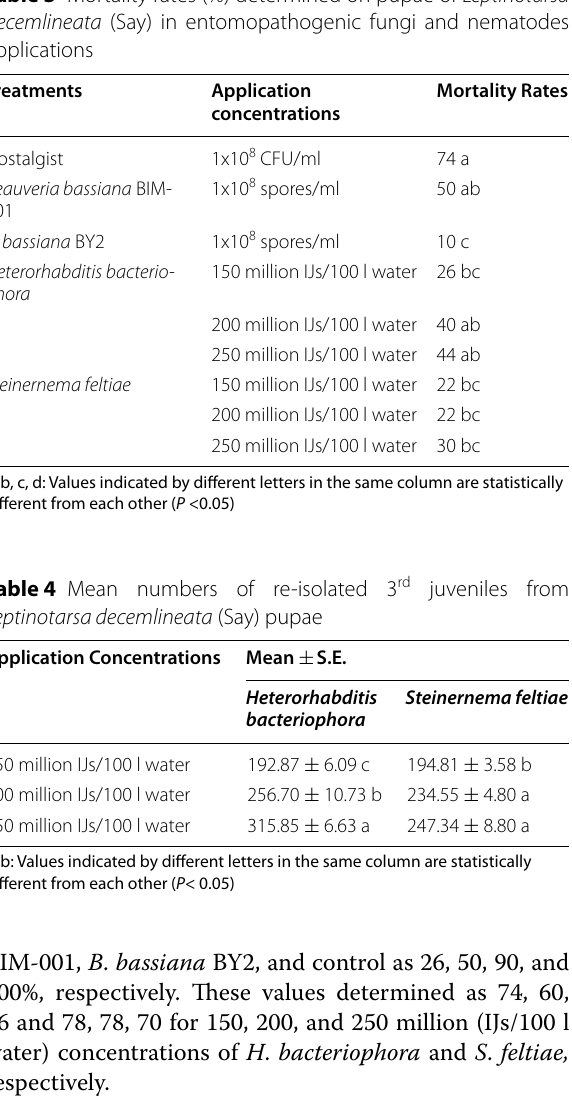
Table 3 Mortality rates (%) determined on pupae of Leptinotarsa decemlineata (Say) in entomopathogenic fungi and nematodes applications